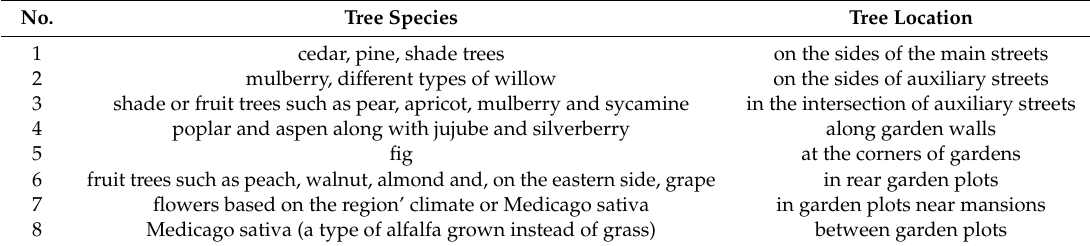
fruit trees such as peach, walnut, almond and, on the eastern in rear garden plots side, grape 7 flowers based on the region’ climate or Medicago sativa in garden plots near mansions 8 Medicago sativa (a type of alfalfa grown instead of grass) between garden plots Table 1. Location and species of trees. (Numbers guide in Figure 3).